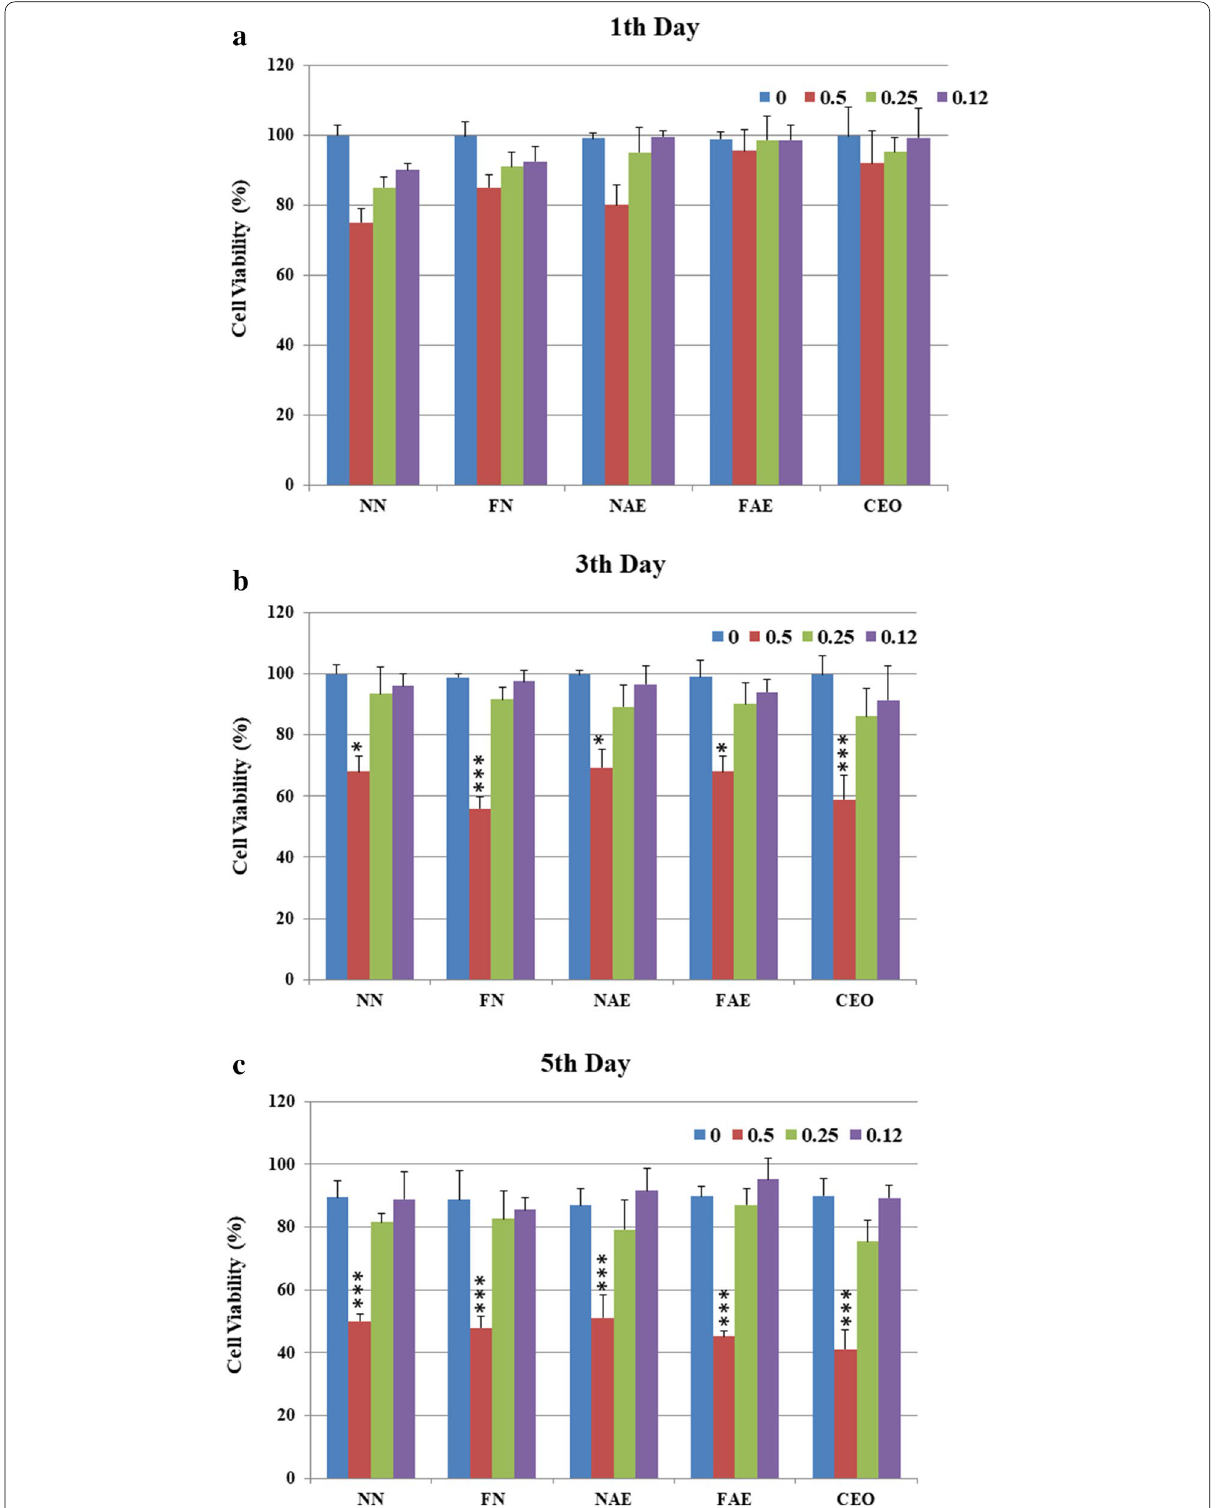
Fig. 9 The cytotoxicity curves of samples in different concentrations for a 1 day, b 3 days, and c 5 days by HEK239